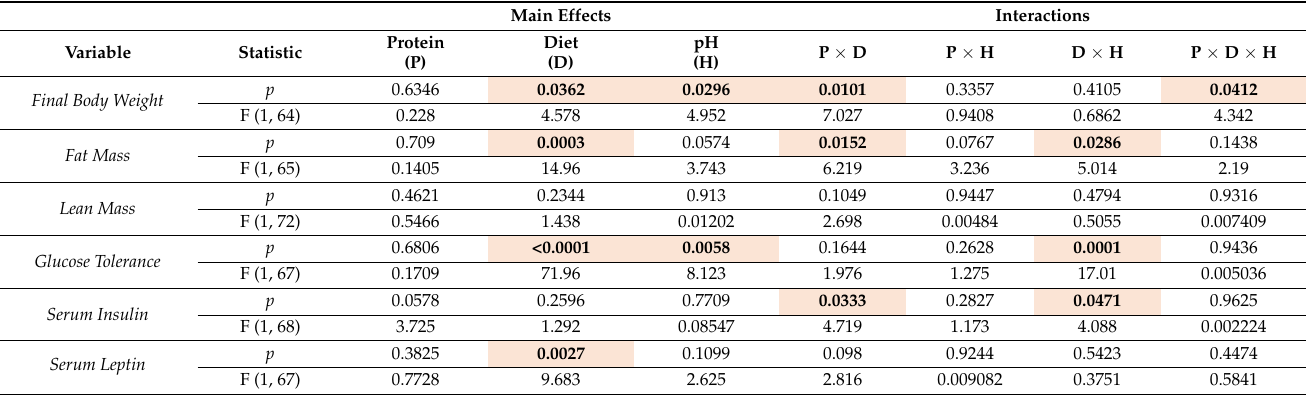
Table 2. Effects of protein, diet, and pH on body weight and body composition, glucose tolerance and serum markers in B6 female mice. P and F values of three-way ANOVA to evaluate main effect and